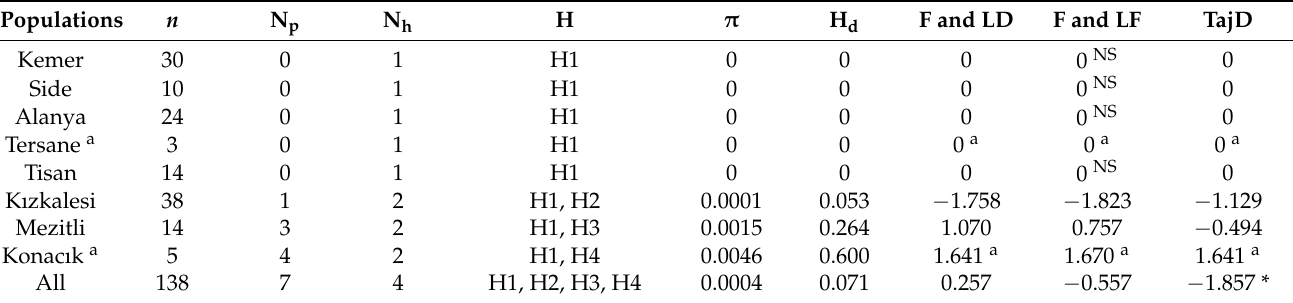
Table 2. Genetic diversity indices and neutrality test statistics per NEMS geographical population based on COI sequences. Sequence numbers ( n ), number of polymorphic sites (N p ), number of haplotypes (N h ), observed haplotypes (H), nucleotide diversity ( π ), haplotype diversity (H d ), Fu and Li’s D (F and LD), Fu and Li’s F (F and LF), and Tajima’s D (TajD). a : These groups have small population sizes ( n < 10). Statistical significance: p < 0.05